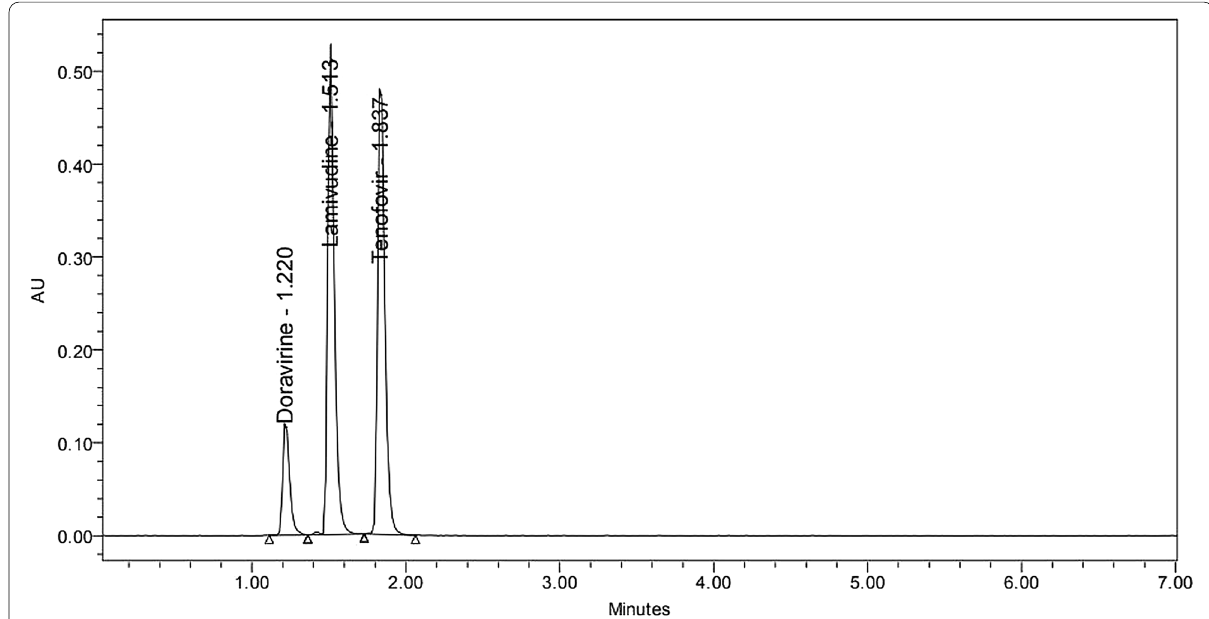
Fig. 9 Chromatogram of the photo degradation solution